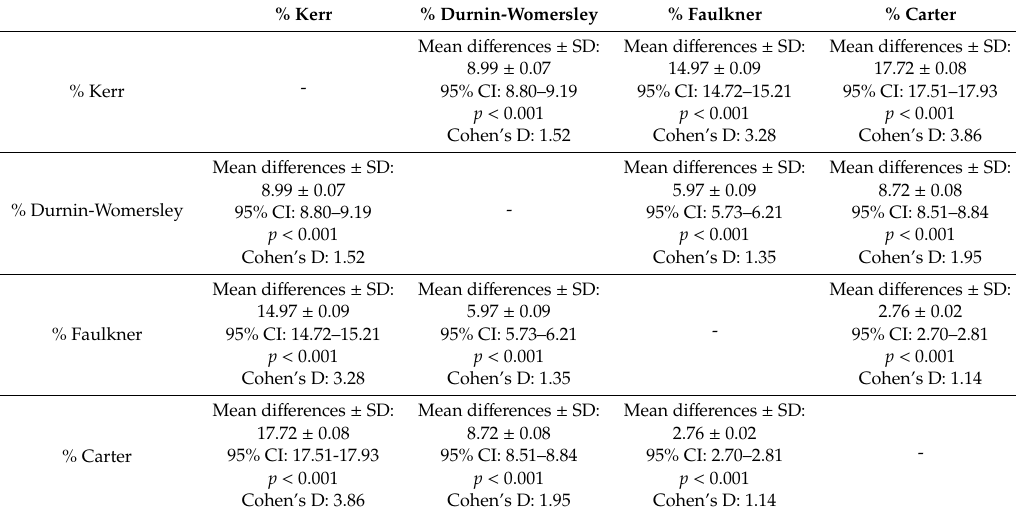
Table 3. Di ff erences between fat mass equations in percentages.